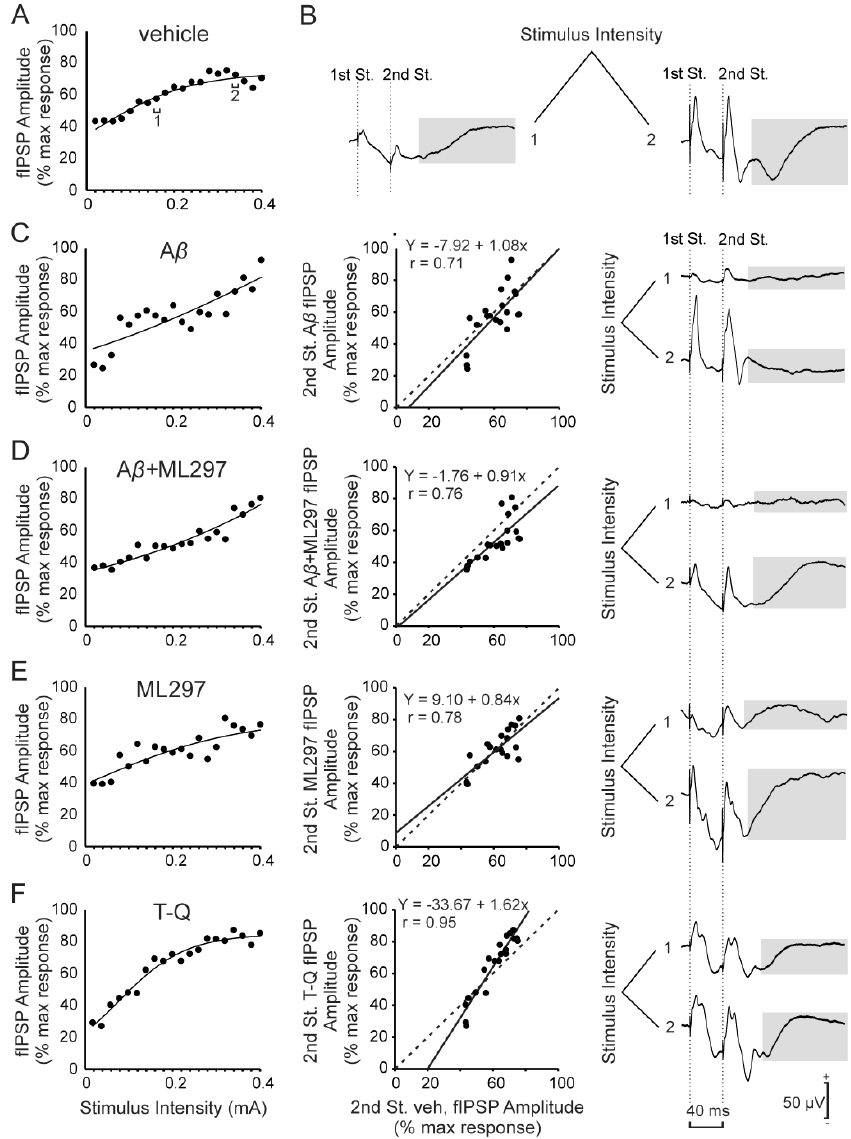
Figure 3. I/O curves for the GirK-channels-dependent inhibitory potential. ( A ) and left panel of ( C – F ), relationship between the intensity (mA) of pairs of stimuli (40 ms of interval between stimuli) applied to the Schaffer collaterals and the amplitude of the metabotropic GABAergic fIPSPs evoked in the CA1 region, corresponding to the second pulse. For each intensity of stimulation, circles represent the average of the response for all the animals of each experimental group. To facilitate the interpretation of the data, error bars have been omitted and the best sigmoid fit to the data for each group of animals has been illustrated (r ≥ 0.95 except for group A β , r = 0.845, and for group ML297, r = 0.857, p < 0.001). Center panel of ( C – F ), scatter plots and linear fits (continuous black lines) illustrating the amplitude values of fIPSP evoked by the second pulse in each experimental group vs. vehicle (control) group (x-axis, vehicle; y-axis, experimental group). Dashed lines represent the linear fit for the control conditions (vehicle vs. vehicle) and are equal in ( C – F ). The values of the slopes for these linear fits were compared with the control to study changes in the activity or tone of this inhibitory postsynaptic potential. Note changes induced by T-Q injection in the slope of the linear fit, which are opposite to the effect of ML297. ( B ) and right panel of ( C – F ) Averaged recordings ( n = 5) representative of the